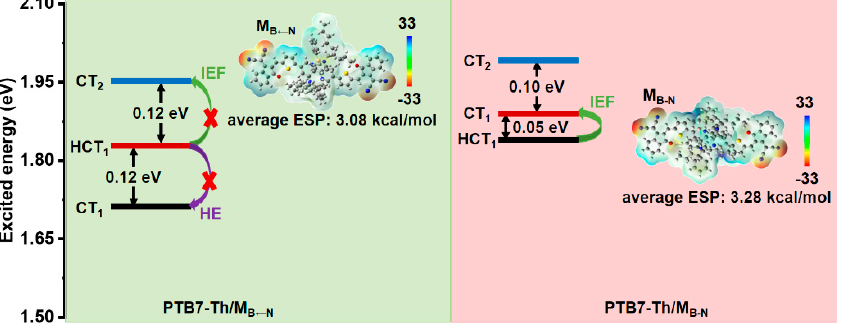
Figure 5. Charge-transfer mechanisms of the lowest three excited states (S 1 -S 3 ) for the studied molecular interfaces (IEF: intermolecular electric field mechanism; HE: hot exciton mechanism; ESP: electrostatic potential).